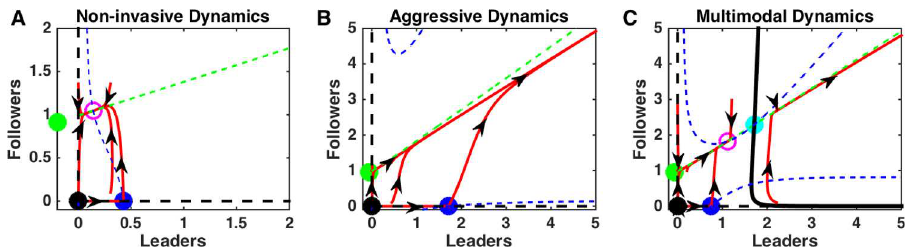
Fig 9. Competition and invasion determine diverse of dynamics when transitions from followers to leaders are possible. Transition rates from followers to leaders were modeled by a single source term, r , positive for Eq (1) and FL F negative for Eq (2). A) A single stable steady state (non-invasive dynamics) when invasion is low and competition is high: s and c = 0 . 6 .B) No stable steady states (aggressive dynamics) when invasion is high and competition is low: L = 1 s L = 2 . 75 and c = 0 . 275 .C) Outcome depends on initial condition (multi-modal dynamics) when both invasion and competition are moderate: s and c = 0 . 375 .For all cases s , s . 5 ,and r . 01 L = 2 LF = 1 FL = 0 FL = 0